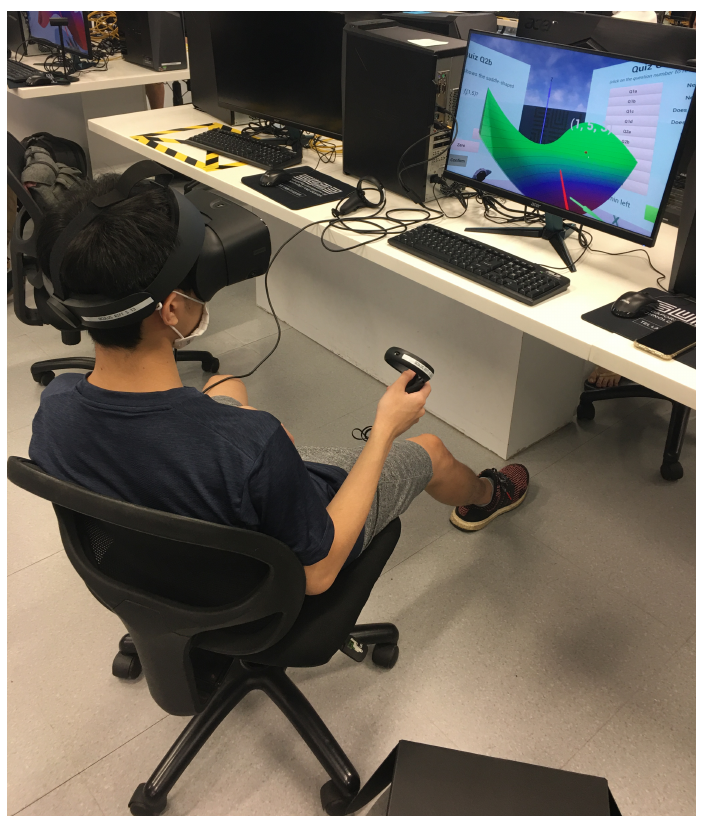
Figure 1. A student participating in the treatment test using the Oculus headset and one handheld